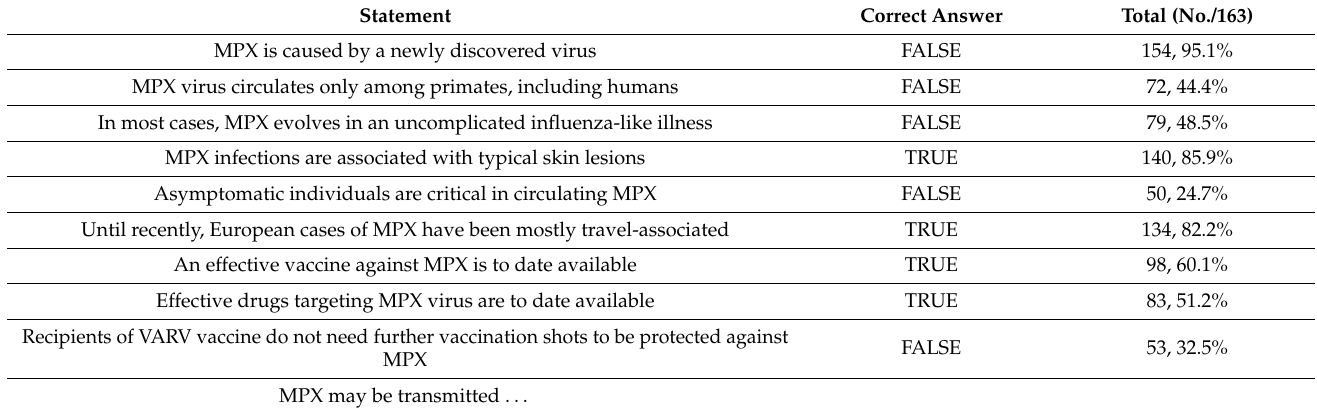
Table A3. Knowledge test: response distribution of presented items proposed to the 163 medical professionals participating in the survey and contributing to the assessment of general